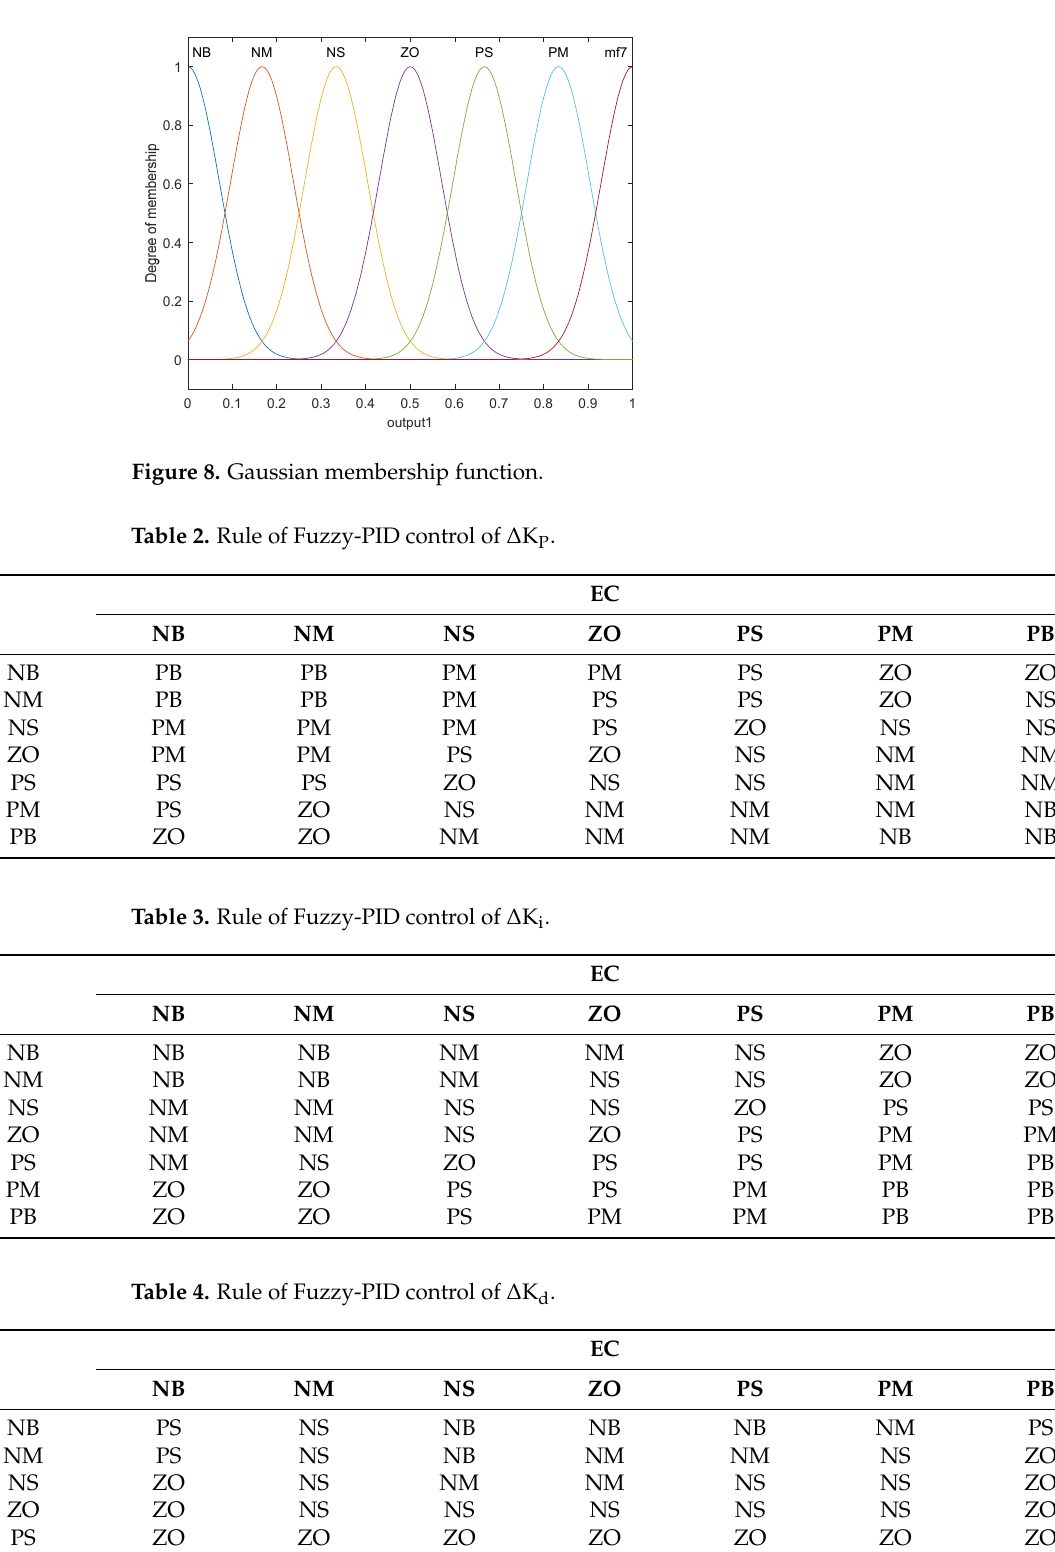
Figure 7. Triangular membership function.